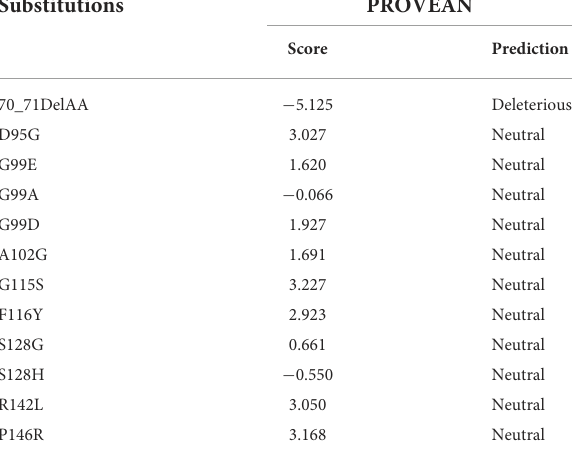
TABLE 4 In silico evaluation of the effect according to the substitutions of the canine shadow of prion protein (Sho) using